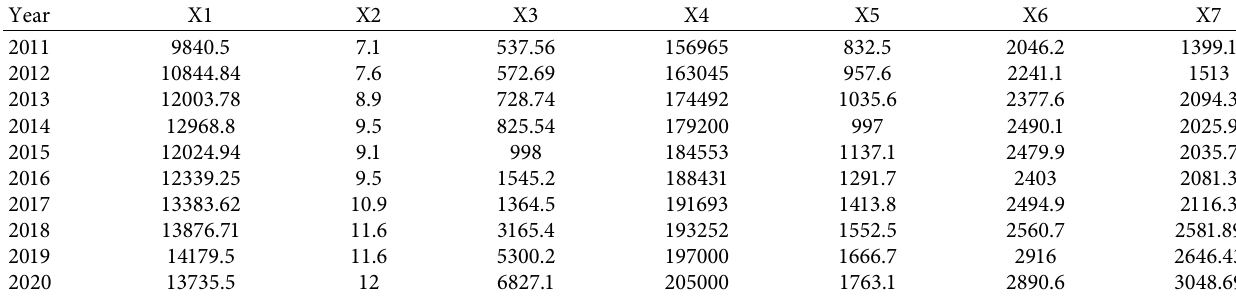
Table 5: Original data on logistics indices.